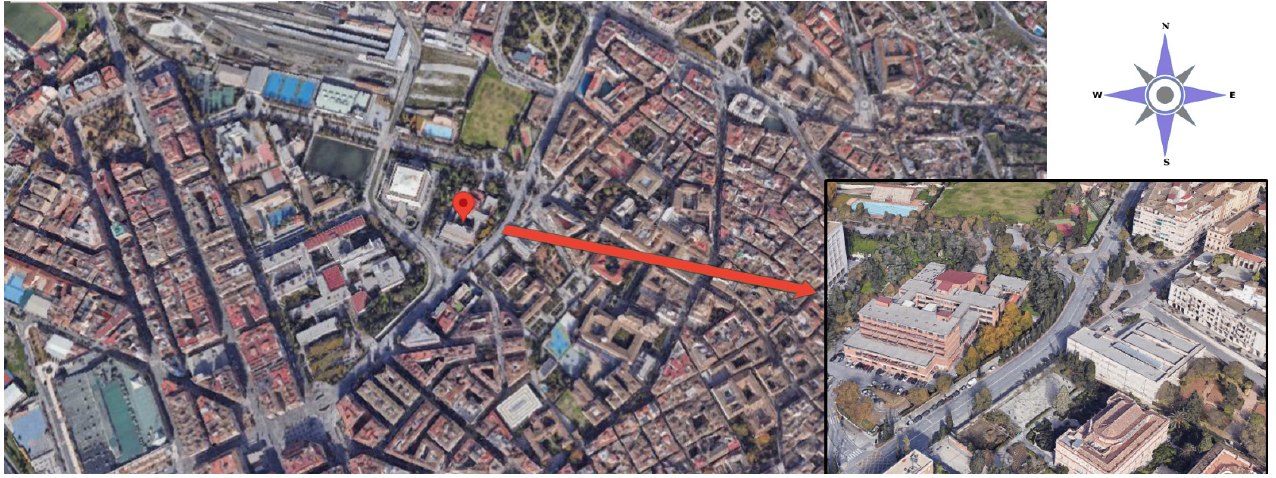
Figure 1. Location of case study.